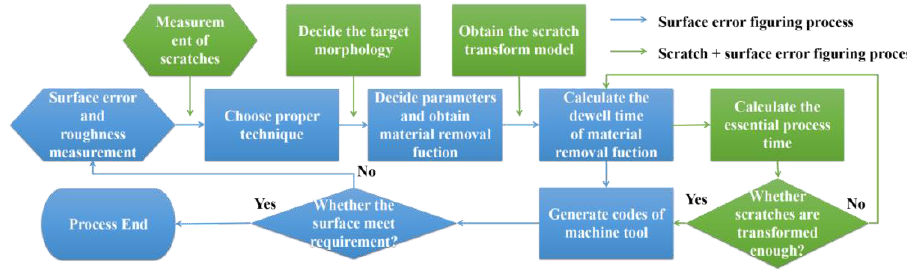
Figure 1. The combined process of scratch transform and surface error